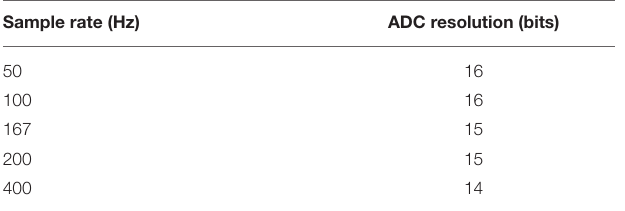
TABLE 2 | Maximum available ADC resolution for each sample rate configuration